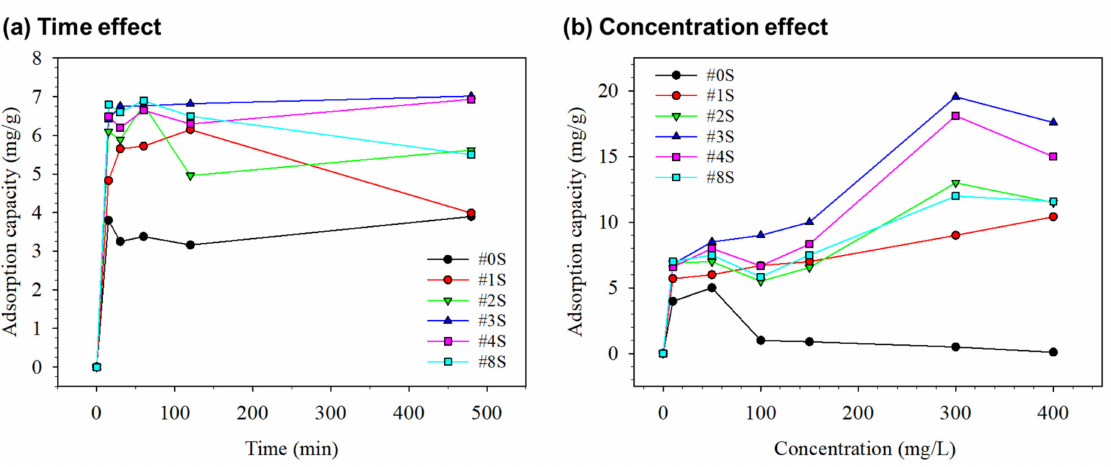
Figure 6. ( a ) Time interval and ( b ) concentration’s effect of adsorption of Cu 2+ on various